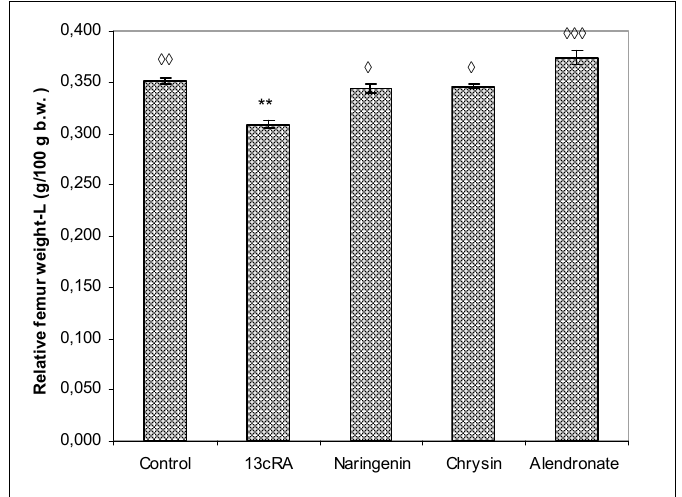
Figure 3. Effects of naringenin, chrysin, or alendronate on relative bone weight of the left-L femur in rats with retinoic-acid-induced osteoporosis. Rats were administered ig with retinoic acid (13cRA) suspension (80 mg/kg) once daily for 14 days. After inducing osteoporosis with 13cRA, rats were administered ig with naringenin (100 mg/kg), chrysin (100 mg/kg), or alendronate (40 mg/kg), once daily for the next 14 days. Relative bone weight was calculated as follows: relative bone weight (g/100 g b.w.) = total bone weight × 100/final body weight. Results are expressed as means of seven samples per group ( n = 7) ± SEM. Data were analysed by the Kruskal–Wallis test. *—Statistically ♦ significant when compared with control (** p < 0.001). —Statistically significant when compared ♦ p ♦♦ p ♦♦♦ p with 13cRA ( < 0.05; < 0.001; <